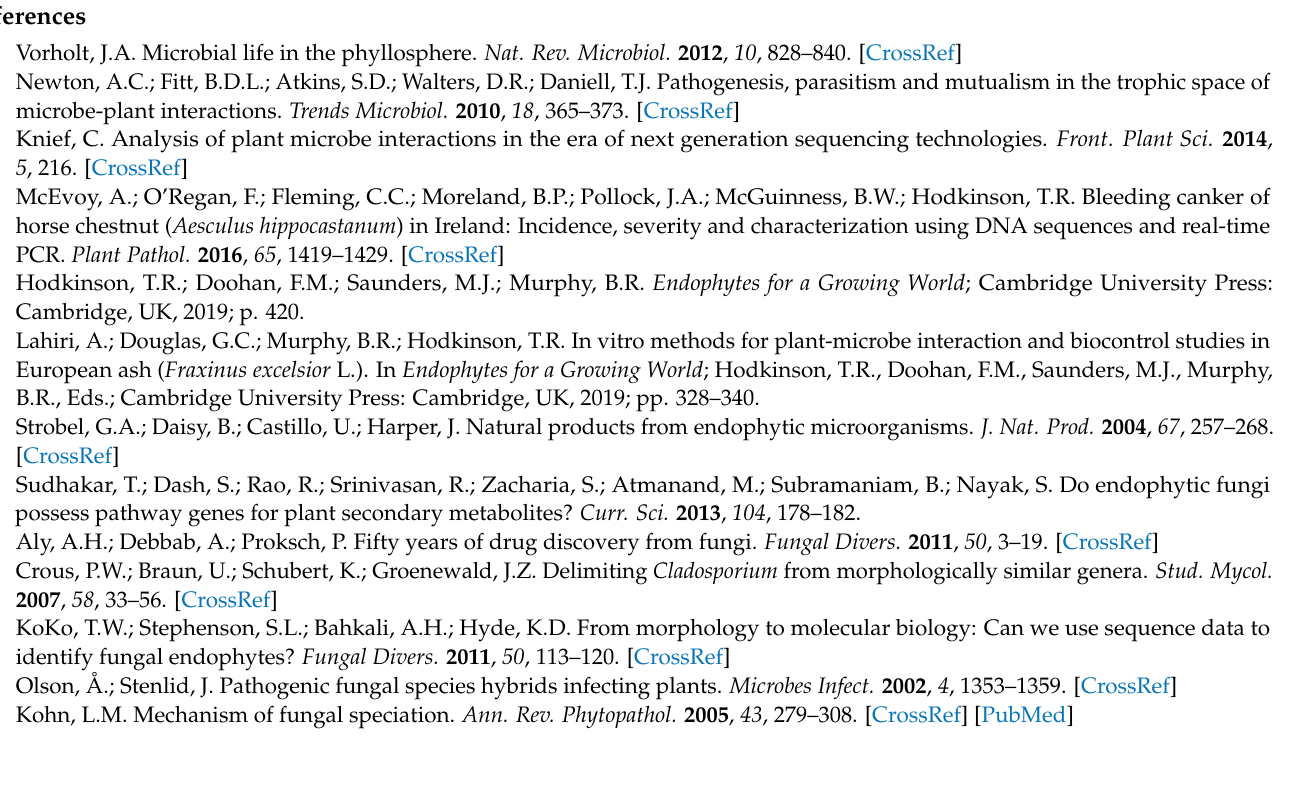
types; Figure S2: Rarefaction curves for all HTS samples; Figure S3: Rank abundance curves for all samples; Figure S4: OTU abundance heat map categorised into phyla, classes, families, or genera of the 70 samples screened with HTS of nrITS; Figure S5: PCoA with unweighted unifrac distances; Figure S6: Heat-map for beta diversity. Table S1: Ash leaflets, seed, and roots collected for fungal isolations, DNA extraction, and HTS; Table S2: Samples selected for HTS Ilumina analysis and their quantity of total DNA; Table S3: Primer information for each DNA barcoding locus used (nrITS, tef , and LSU). Table S4: Frequencies for each of the OTUs at the study sites; Table S5: Total number of isolates and OTUs within each class and family from all leaf and root endophytes; Table S6: OTU frequencies obtained from all sampled leaf tissues from all provenances in the Roosky provenance trial for Fraxinus excelsior ; Table S7: OTUs assigned to respective taxonomic level with total numbers of OTU obtained from seeds and leaves by HTS in the culture independent assessments; Table S8: Dominant fungal endophytes identified from seed taken from two sites, Roosky and Glasnevin, using the HTS of plant material. OTUs highlighted in bold were shared among sites and considered